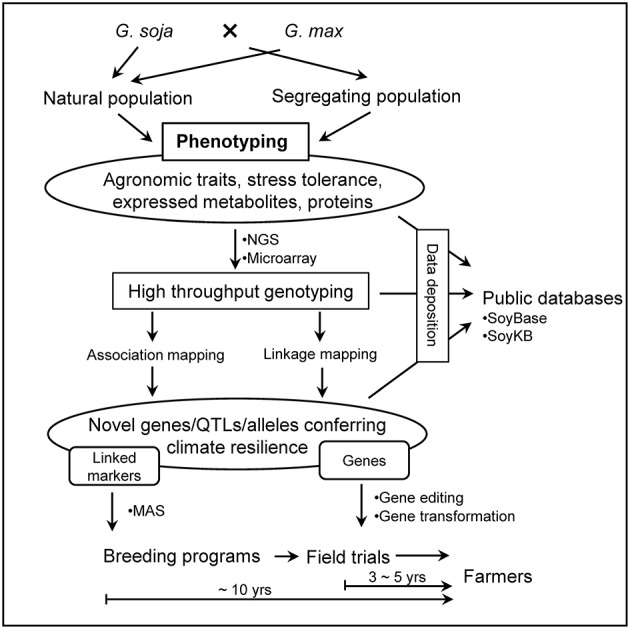
Research pipeline of crop improvement of G. max using G. soja (Fernie and Schauer, 2009).